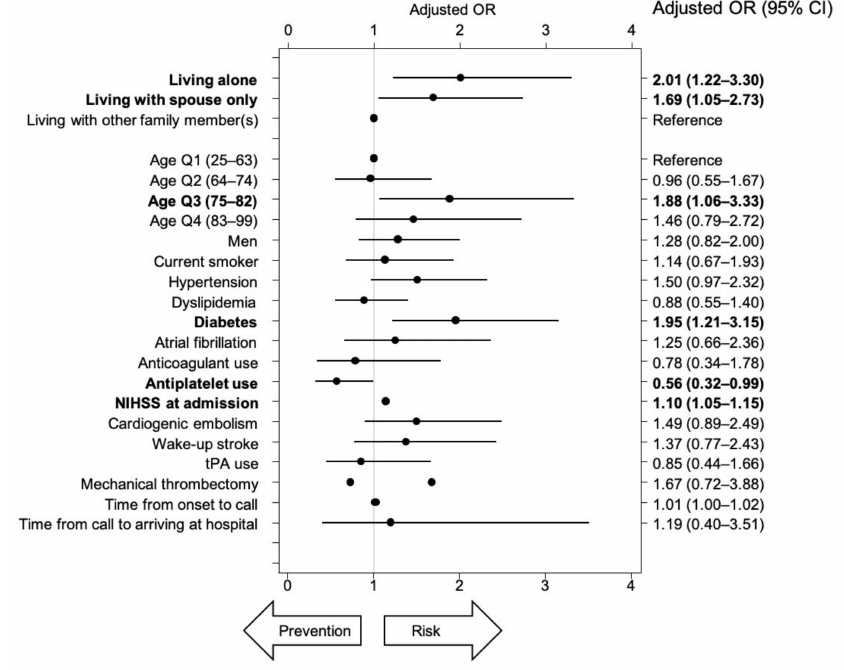
Figure 6. Adjusted odds ratios for changes in the mRS scores after the stroke onset ((mRS score at discharge)—(mRS score before stroke onset)). Bold type shows significant di ff erences in the 95%